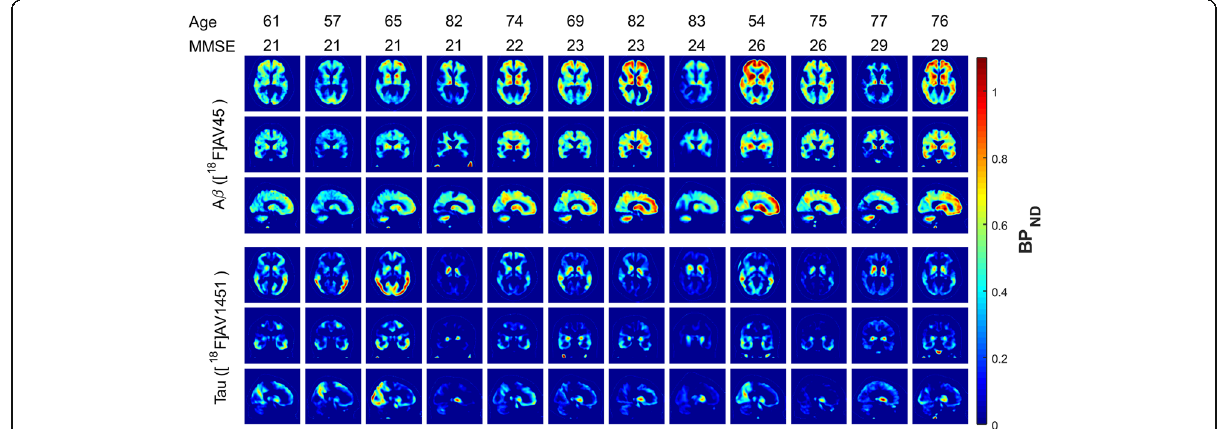
Fig. 6 [ 18 F]AV45 (top row) and [ 18 F]AV1451 (bottom row) uptake patterns in whole brain represented by BP ND values estimated using SRTM for all subjects who completed full 60 min of A β and at least 110 min of tau PET scan. Subjects are ordered based on their MMSE